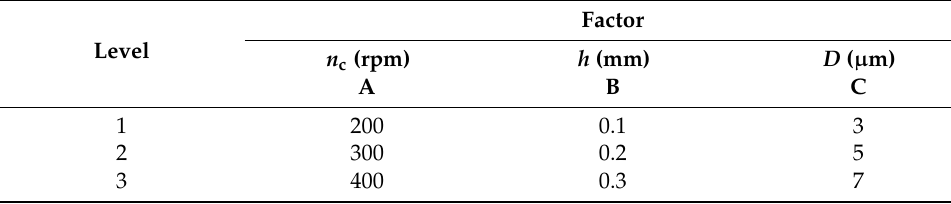
Table 1. Factors and levels of the orthogonal experiment.